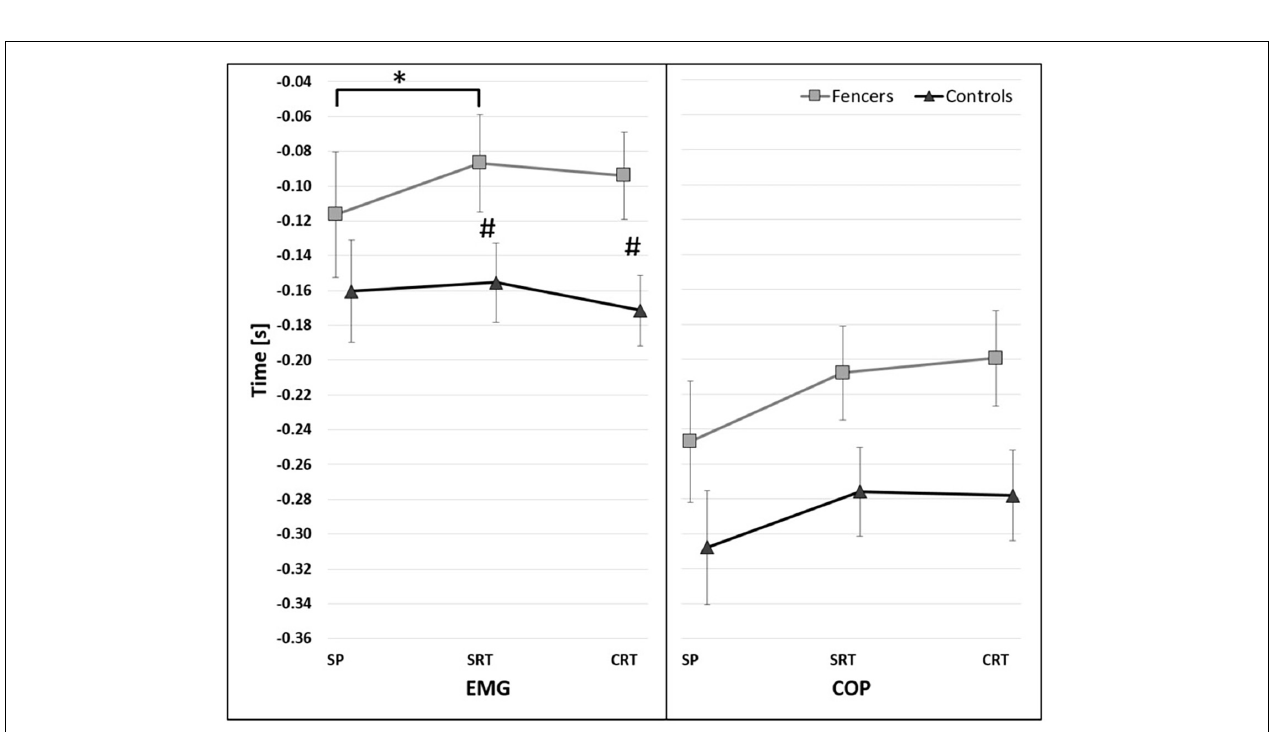
FIGURE 4 | The average time of the onset of TA activity (EMG) and COP displacement (COP) before t 0 for reaction factor (95% confidence interval presented as error bars). The significant differences between reaction time conditions were marked as *.